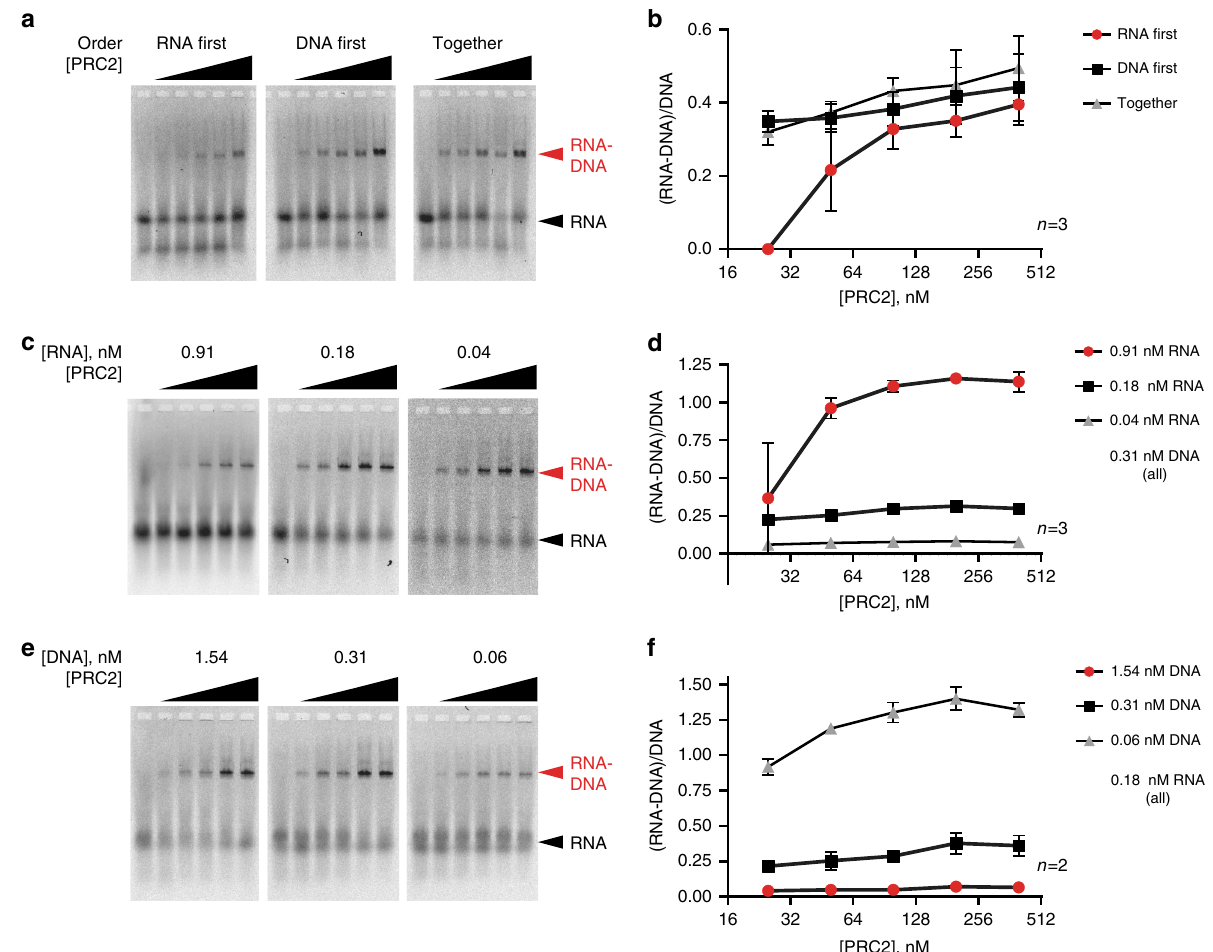
Fig. 6 Characteristics of PRC2 strand exchange activity. In ( a – f ), left panel shows a representative gel of Cy5-labelled RNA, and graph (right panel) summarizes multiple experiments. a , b Effect of order of addition of nucleic acids. c – f Effect of increasing RNA ( c , d ) or DNA ( e , f ). Asterisks: red = 0.91 nM vs. 0.04 nM; black = 0.91 nM vs. 0.18 nM. I- All PRC2 titrations are 25 – 400 nM. All graphs show the mean + / − S.E.M. Source data are provided in Source Data fi